Question: In a single sentence, describe what this figure presents.
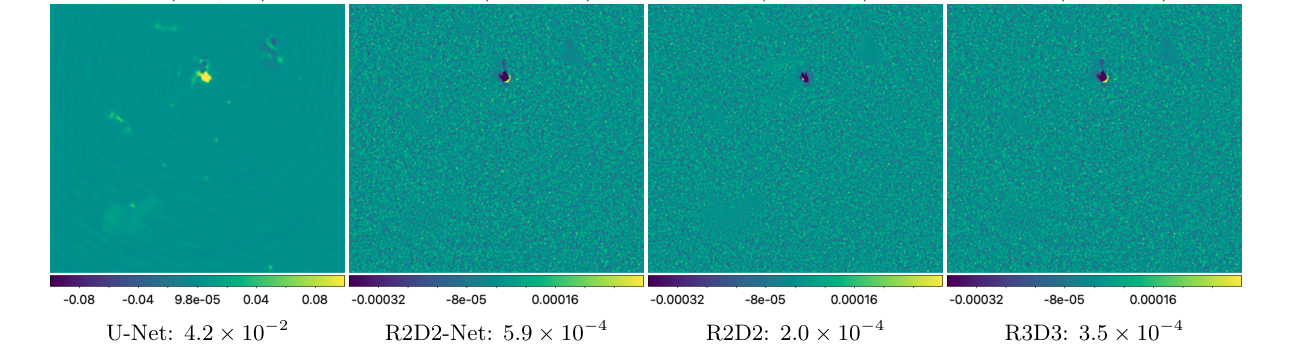
Answer: Experiment III: reconstructions results of the galaxy cluster PSZ2 G165.68+44.01. The first and third rows show the ground truth image and the estimated images obtained by the imaging algorithms (logarithmic scale). The second and fourth row shows the dirty image and the corresponding residual dirty images (linear scale). For R3D3, we showcase the results of its realization with J = 6 layers in its R2D2-Net components. Values of (SNR, logSNR) are reported below estimated images. The σres. values are indicated below the residual dirty images.